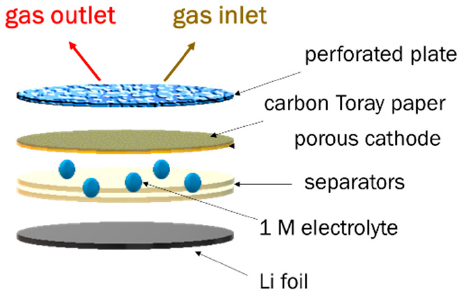
Figure 1. Schematic representation of the Li-air battery.